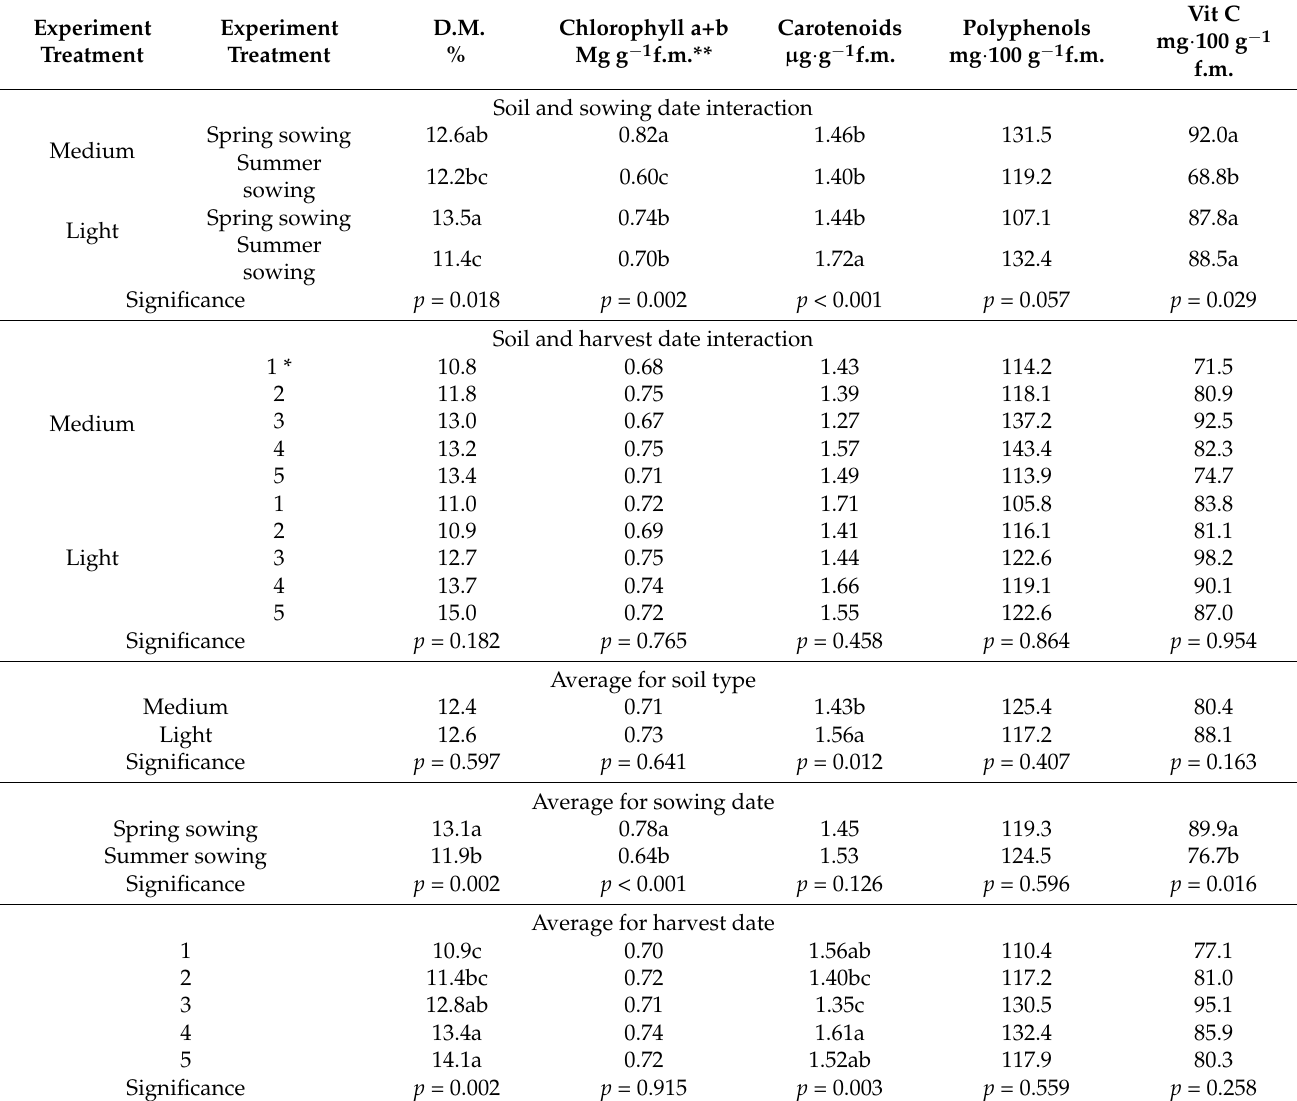
Table 5. The effect of soil type, sowing date and harvest date on quinoa dry matter, chlorophyll, carotenoids, polyphenols and vitamin C content. Average from years